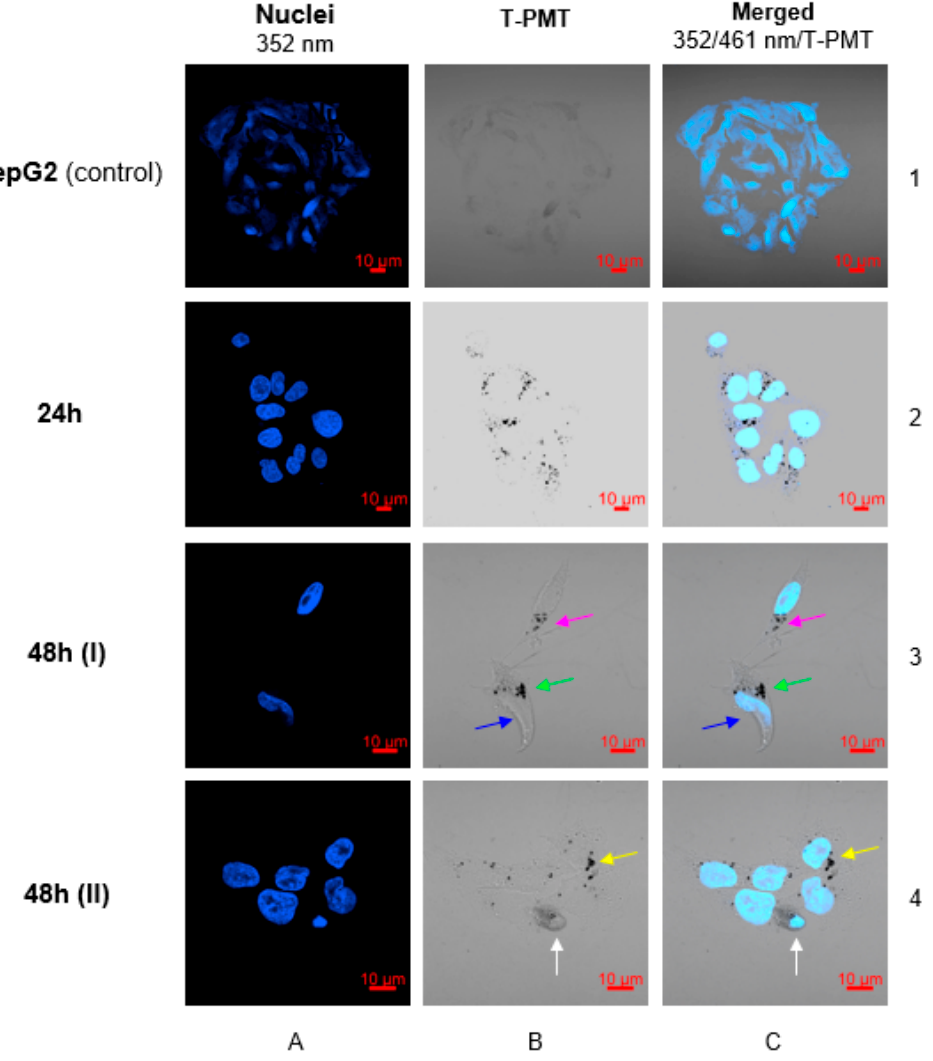
Figure 13. Confocal microscopy images for HepG2 cell line treated with Au@Pt-PEG-COOH after 24 and 48 h. Blue fluorescence—cell nuclei visualized with Hoechst 33258; dark spots—nanoparticles visualized by T-PMT detector. Corresponding signals of nanoparticles in cell area were marked with colored arrows.